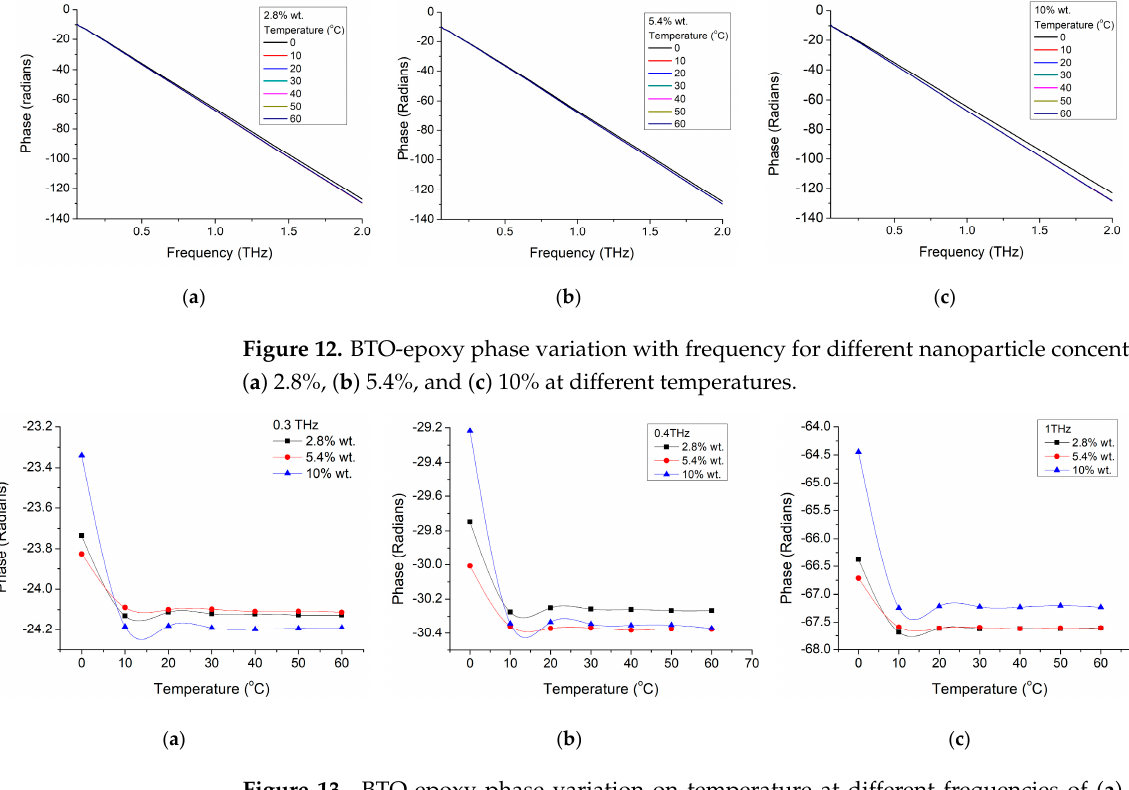
Figure 12. BTO-epoxy phase variation with frequency for different nanoparticle concentrations of ( a ) 2.8%, ( b ) 5.4%, and ( c ) 10% at different temperatures.